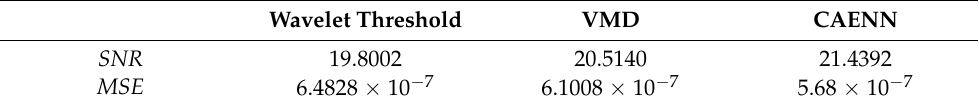
Figure 9. The aerosol extinction coefficient profiles obtained by the Klett method and its denoising effect at a wavelength of 532 nm. ( a ) the original signal, ( b ) the signal processed by the wavelet threshold method, ( c ) the signal processed by the VMD method, ( d ) the signal processed by CAENN method. Table 7. The SNR and MSE of lidar signals denoised by three methods shown in Figure 9.